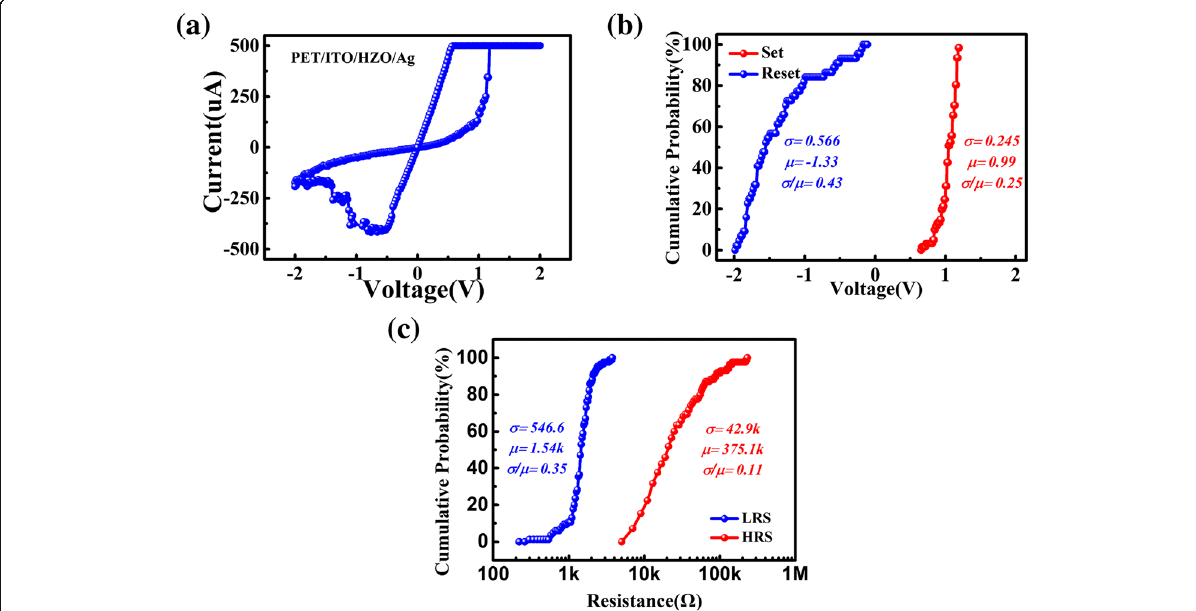
Fig. 2 a Resistive switching characteristics of HZO-based device measured by DC sweep. b Distribution of the set and reset voltages extracted from DC sweep cycles in flexible device. c Statistical data of HRS and LRS, where resistance were measured at a read voltage of 0.1